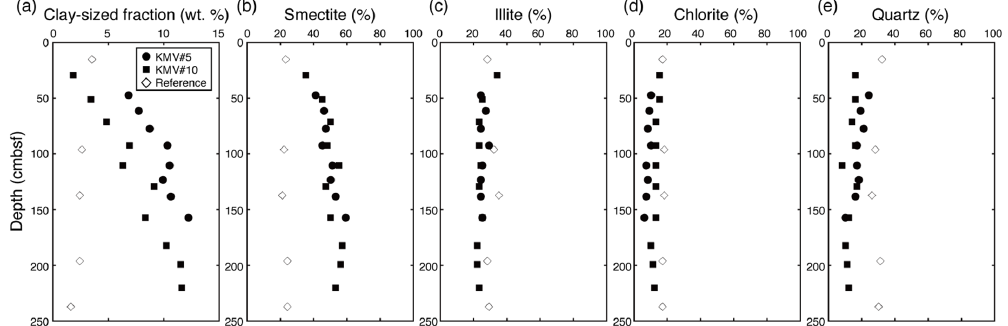
Figure 6. Vertical profiles of ( a ) clay-size fractions and percentages of ( b ) smectite, ( c ) illite, ( d ) chlorite and ( e ) quartz from this study.